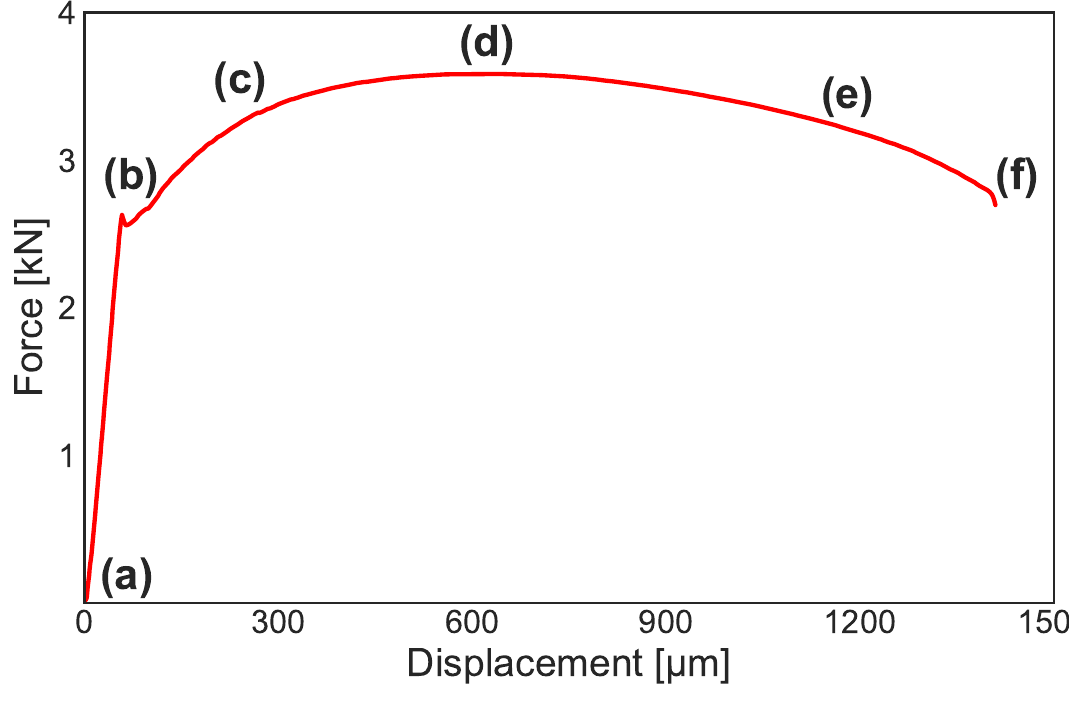
Figure 6. Measured force–displacement curve for the etched specimen during an in situ SEM tensile test. The labels ( a – f ) are related to the micrographs in Figures 7 and